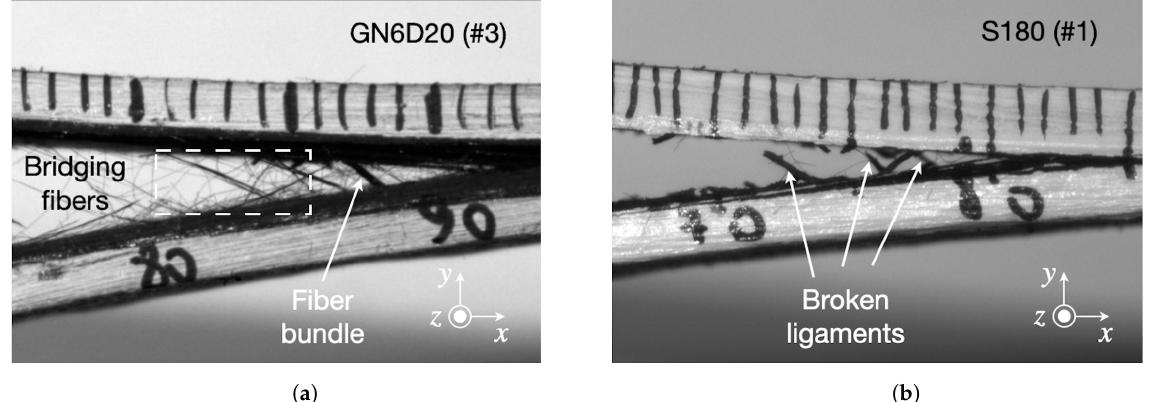
Figure 12. Typical mechanisms of damage recorded in ( a ) grit-blasted (GN6D20) and ( b ) sanded (S180) CFRP/epoxy joints recorded during the experiments.